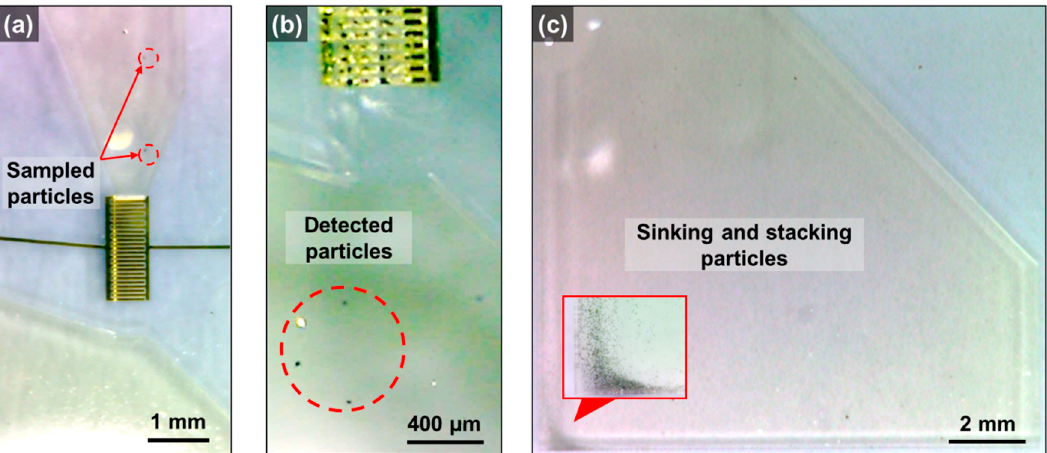
Figure 16. Video frames of particle delivery on the proposed system; ( a ) delivered particles at the inlet of the detection region, ( b ) detected particles at the outlet of the detection region, and ( c ) accumulated particles on the bottom of the oil reservoir.